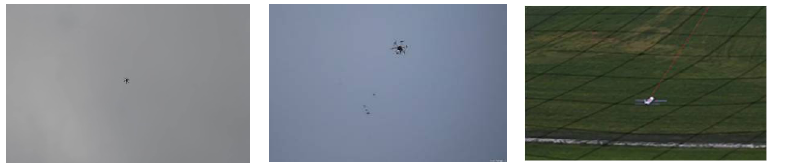
Figure 2. Some samples of challenges related to the different weather conditions and crowded background.